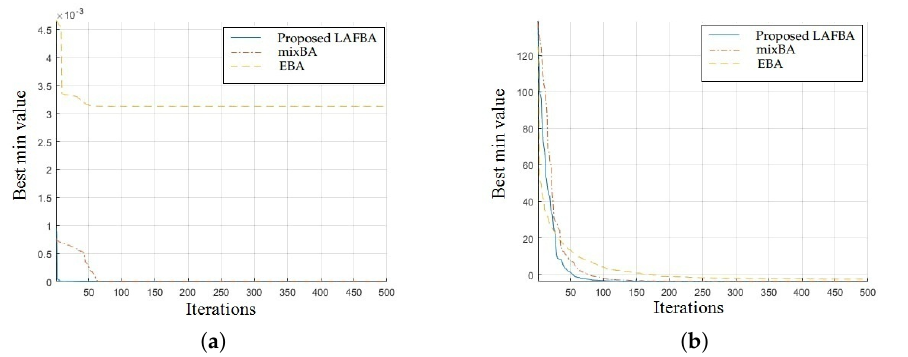
Figure 6. ( a ) Schaffer function convergence graph. ( b ) Styblinski–Tang function.